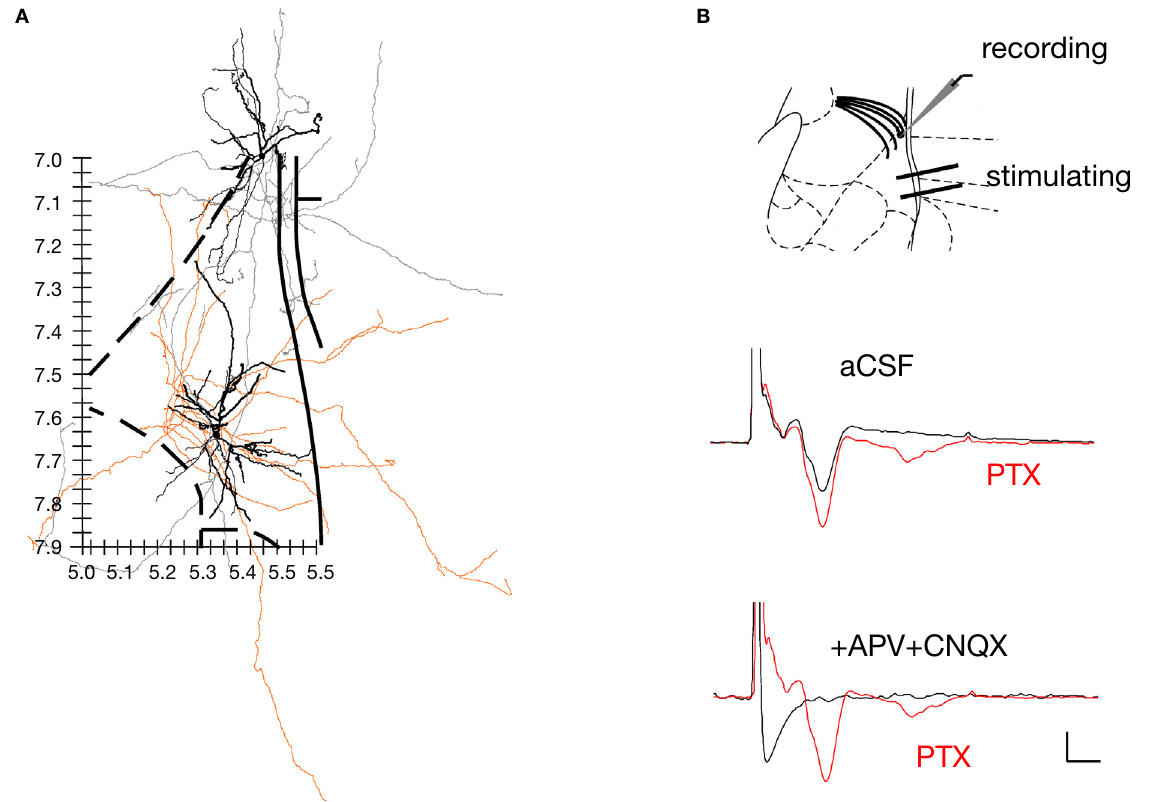
Figure 7 | Direct evidence for a functional ventral to dorsal LAd network. (A) Spatial organization of axon collaterals arborizing from two example neurons located in LAd-s and LAd-i. Dendrites are depicted in black and axons in grey (LAd-s) and orange (LAd-i). Note the axon collaterals from the LAd-s reach the vicinity of dendrites from the LAd-i neuron, and axon collaterals from the LAd-i reach the vicinity of dendrites from LAd-s neuron. Scale (mm) and outline from Paxinos and Watson 4th Ed. (B) Bipolar stimulating electrodes were placed in the LAd-i, and recordings were made from LAd-s. Stimulation of LAd-i evoked monosynaptic FP in the LAd-s. In the presence of PTX (75 μ M) the monosynaptic potential increased in amplitude and polysynaptic activity is observable. The FP is eliminated by glutamatergic antagonism (10 μ M CNQX + 100 μ M